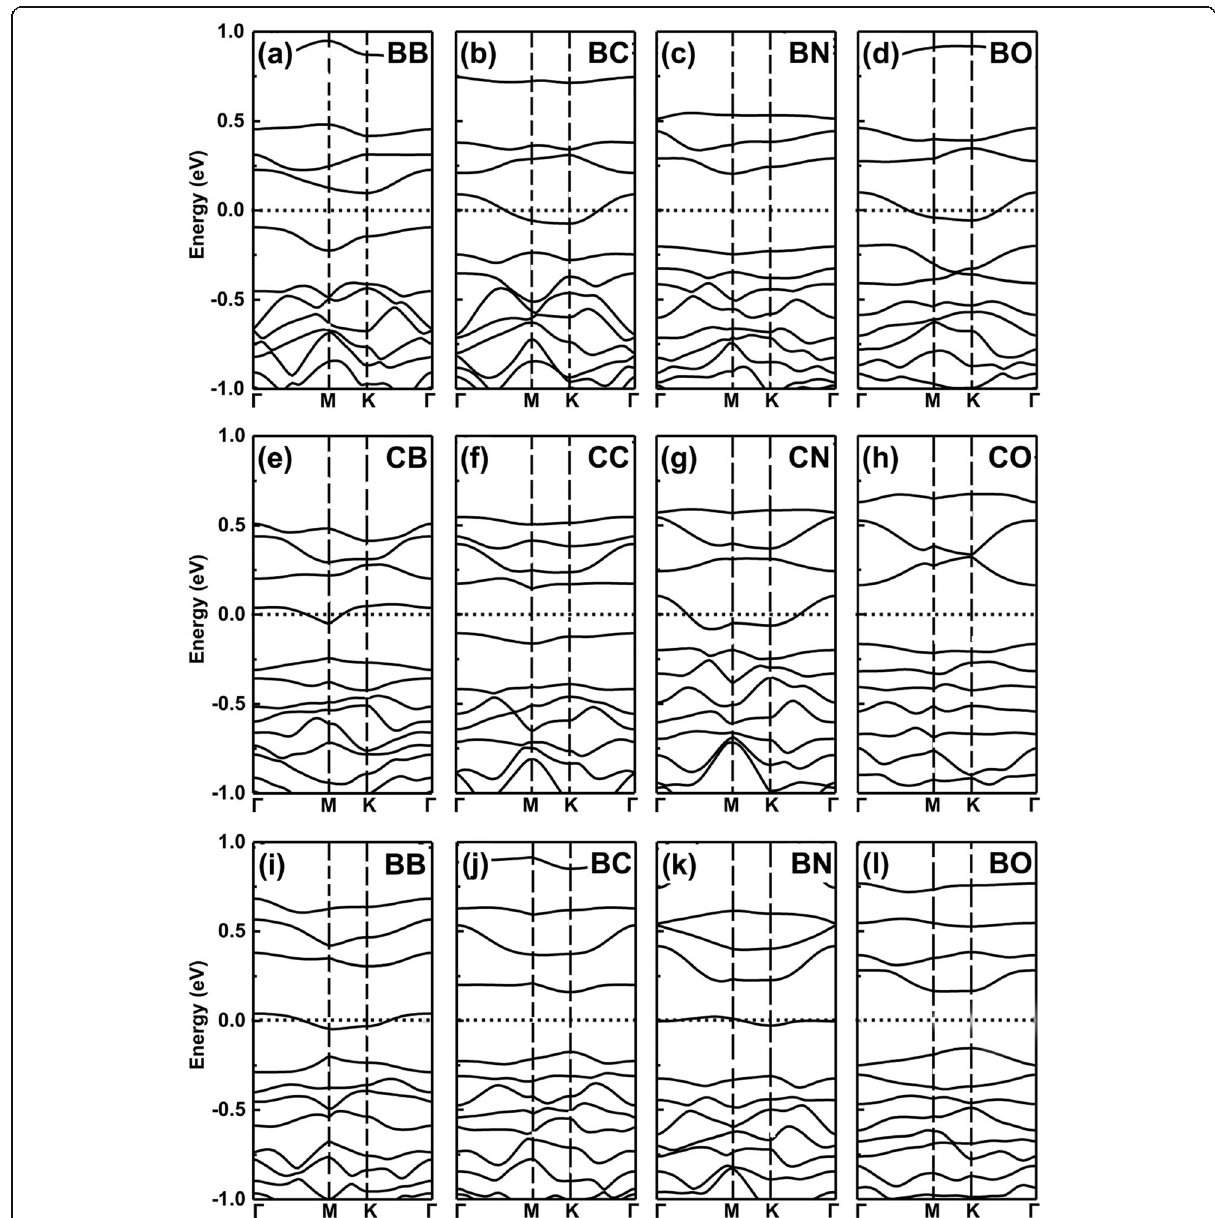
Fig. 6 Band structures of co-doped systems. The band structures of B, C, N, and O co-doped GeP 3 monolayer. a – d The two dopants substitute two Ge atoms in GeP 3 monolayer, e – h the two dopants substitute two P atoms, i – l the two dopants substitute one Ge atom and one P atom,